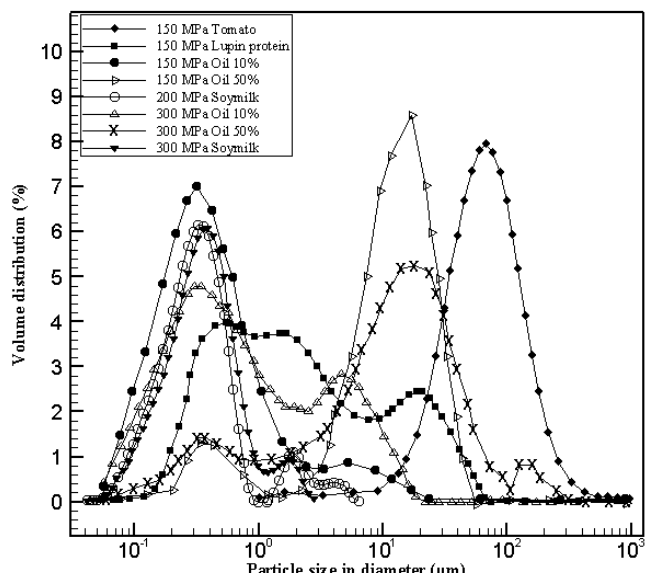
Figure 8: Effect of homogenizing pressure conditions of 50-300 MPa on droplet size distributions of 10% and 50% oil concentration of O/W emulsions, tomato based, lupin protein and soymilk products [1, 6, 9, 11].